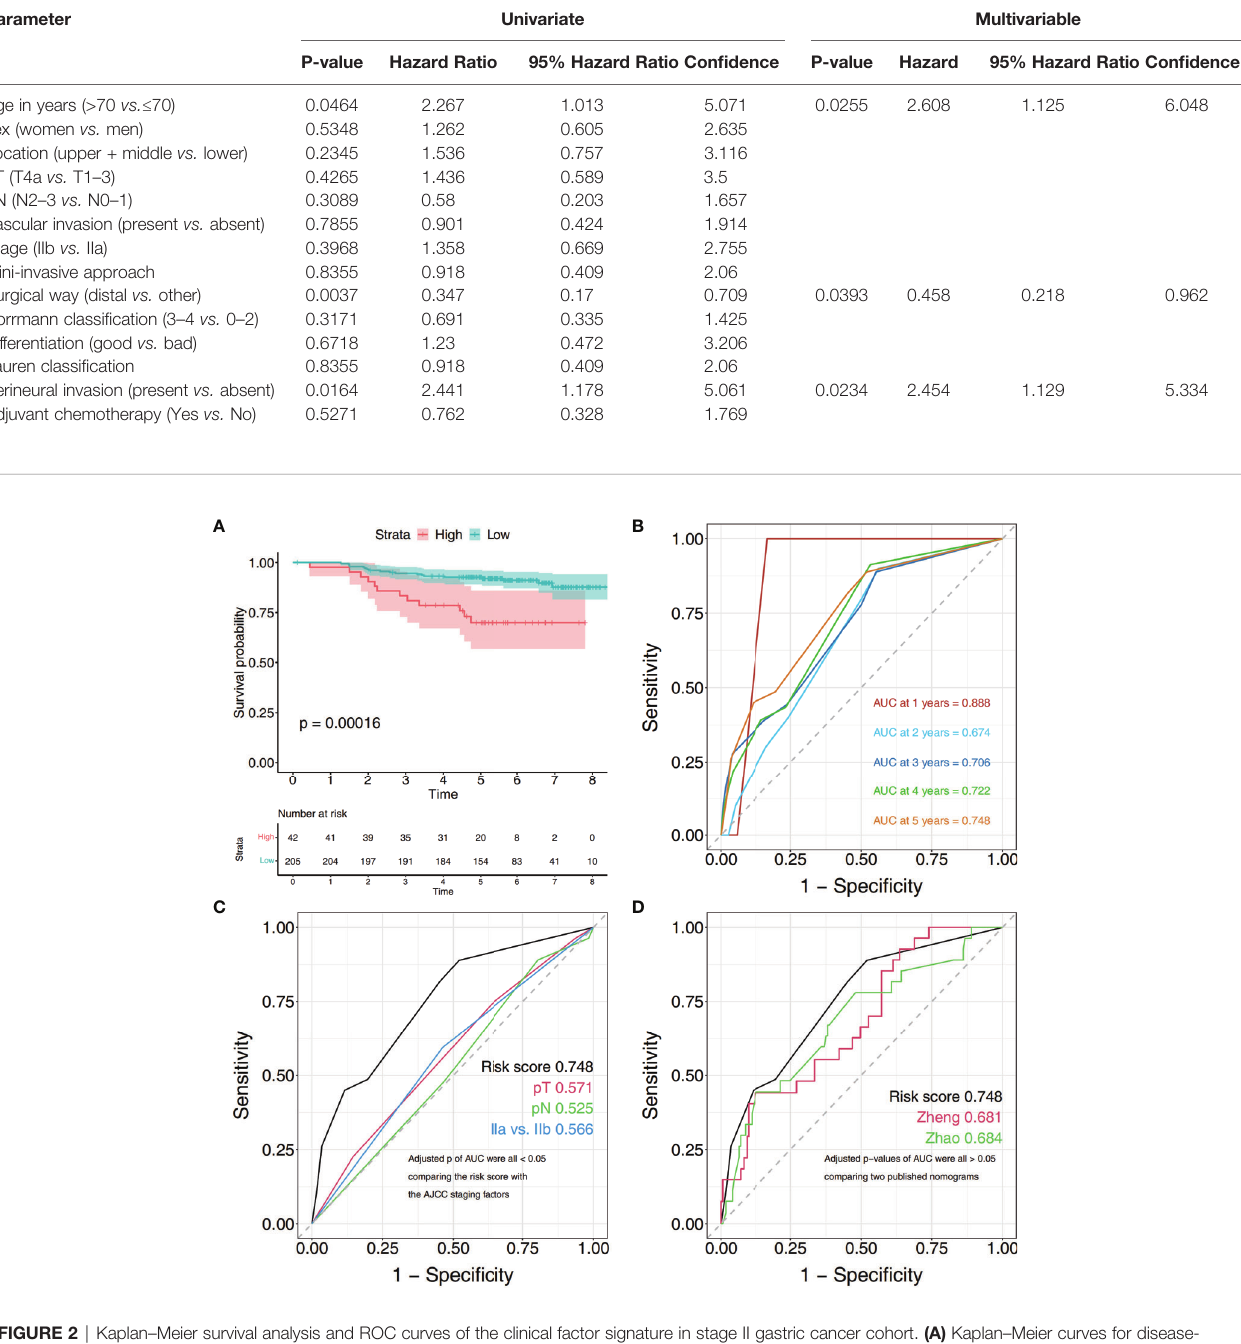
FIGURE 2 | Kaplan – Meier survival analysis and ROC curves of the clinical factor signature in stage II gastric cancer cohort. (A) Kaplan – Meier curves for disease- speci fi c survival of patients grouped by risk scores. (B) Time-dependent ROC analysis was performed to assess the prognostic accuracy, and P values were calculated using the log-rank test. (C) The risk score model has better prediction value than staging factors in stage II gastric cancer (pathological tumor stage, pathological nodal stage, and pathological AJCC stage). (D) Comparison of ROC curves of our risk model and others predicting survival. ROC, the receiver operating characteristic; AUC, area under